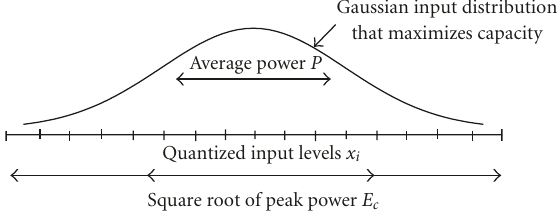
Figure 1: Peak power of quantizer is larger than average power im- posed.